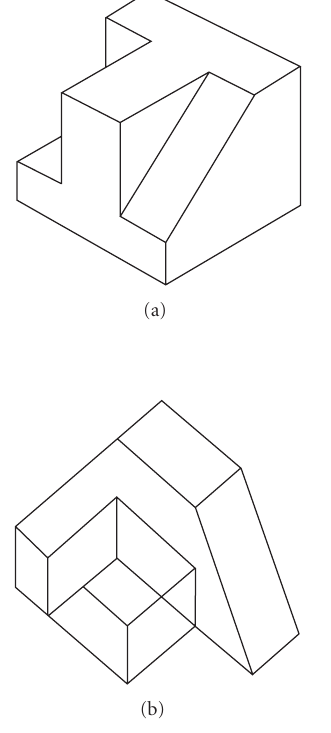
Figure 1: Examples of the visual stimuli used in the IP-OD task: (a) “possible” object; and (b) “impossible”